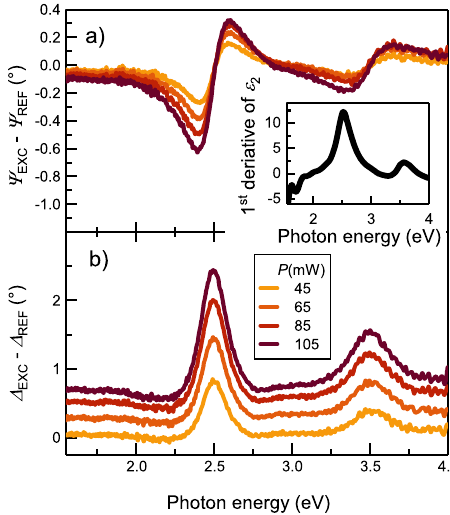
Fig.2|Measuredellipsometricdifferencecurvesforsurfaceplasmonpolariton excitations at different laser powers. a Differences in psi spectra and ( b ) differ- ences in delta spectra. Note that delta values ( b ) are offset for better visibility. The inset shows the fi rst derivative of the imaginary part of the dielectric function of gold determined in this study. Peak positions in the ellipsometric curves corre- spond to rapid changes in the dielectric function of gold, i.e. peaks in its fi rst